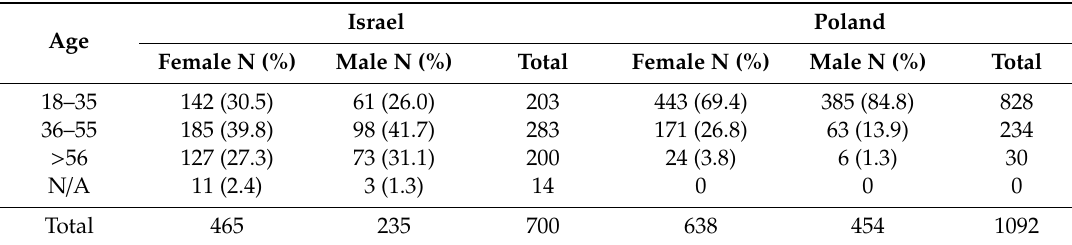
Table 2. Age of study populations.